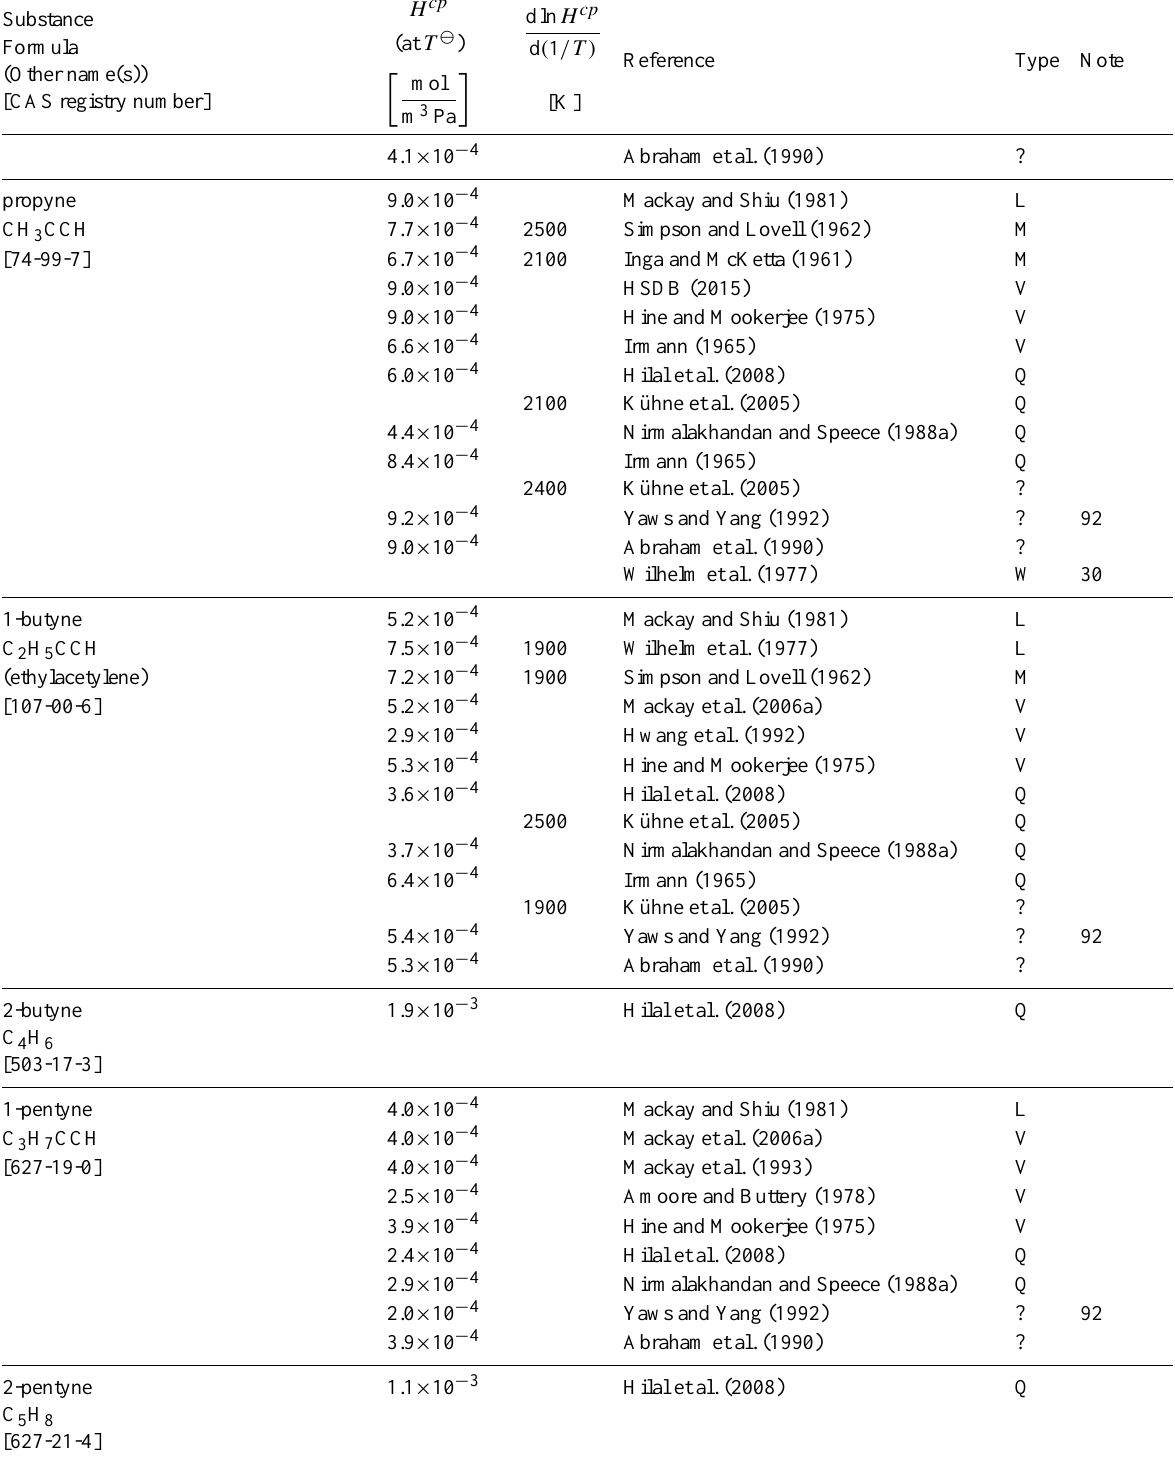
Table 6: Henry’s law constants for water as solvent